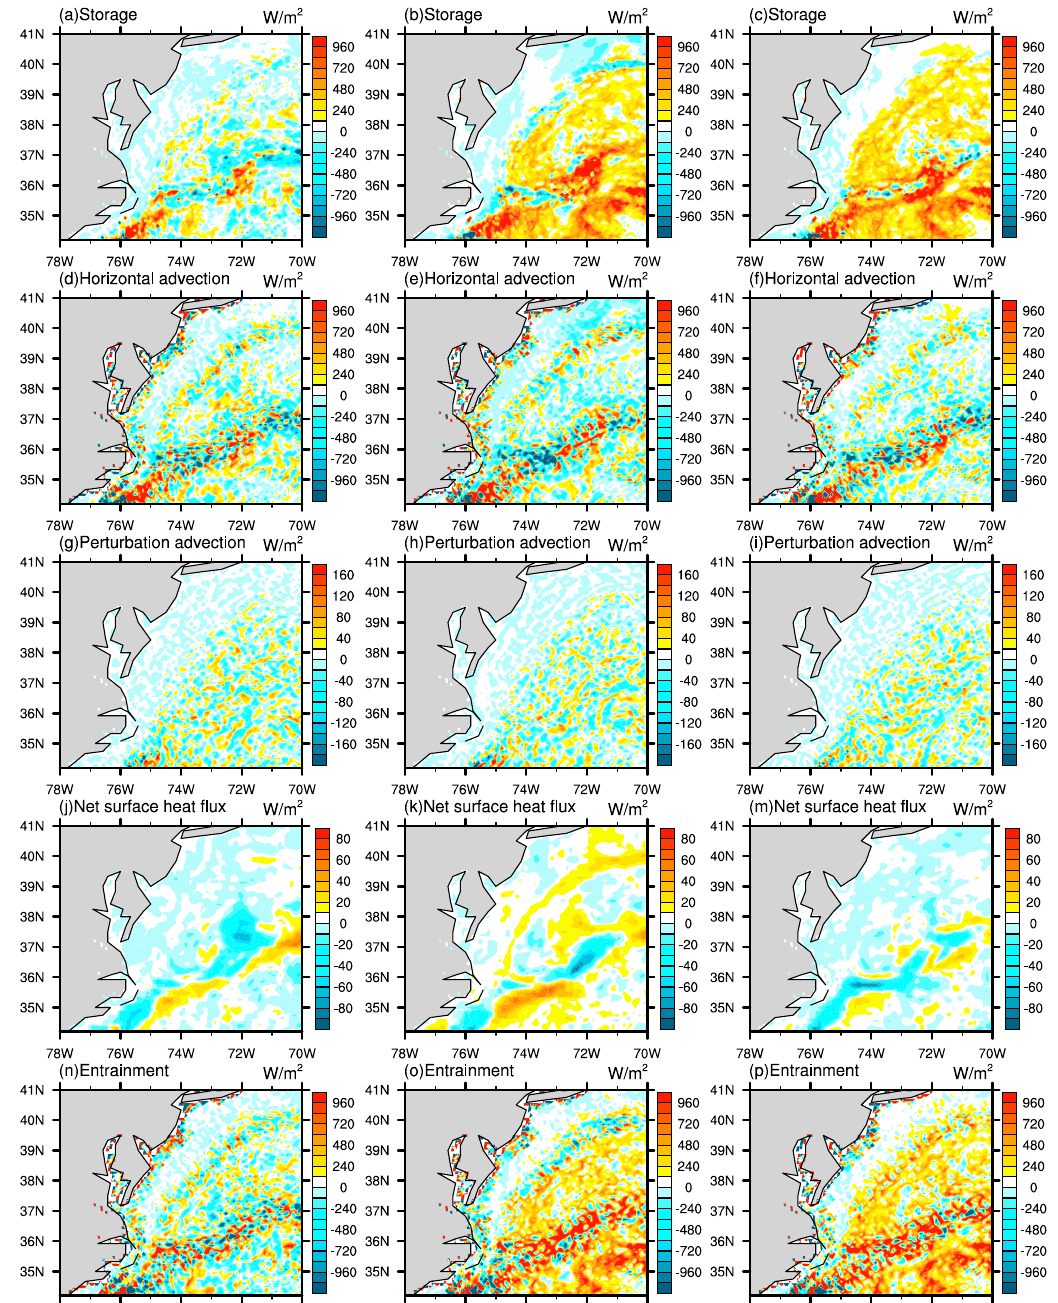
Figure 9. The changes in the budget terms: ( a – c ) heat storage; ( d – f ) mean horizontal advection; ( g – i ) perturbation horizontal advection; ( j – m ) net surface heat flux; ( n – p ) vertical entrainment for current–stress coupling (CUR–CTL, left panel), wave–stress coupling (WAV–CTL, middle panel), and current–wave–stress (CUR_WAV–CTL, right panel) coupling.